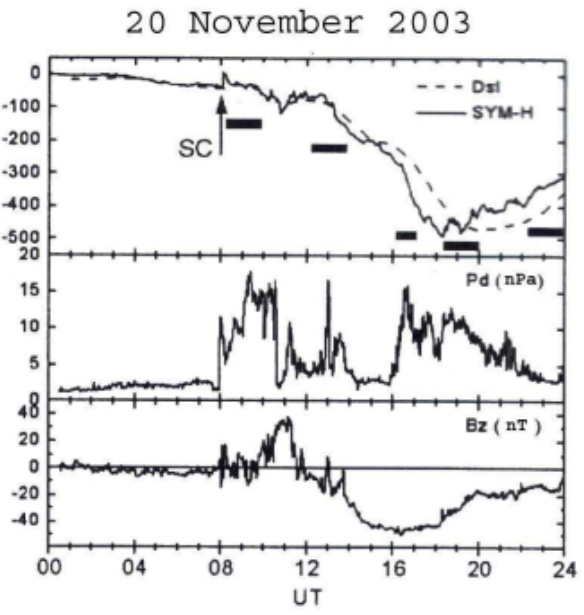
Fig. 1. Variations of the D st and SYM-H indices (in nT), solar wind dynamic pressure Pd (in nPa), and B z IMF component (in nT) in the course of magnetic storm on 20 November 2003. Figure 1. Variations of the Dst and SYM-H indices (in nT), solar wind dynamic pressure Pd (in nPa), and Bz IMF component (in nT) in the course of magnetic storm on 20 November 2003.